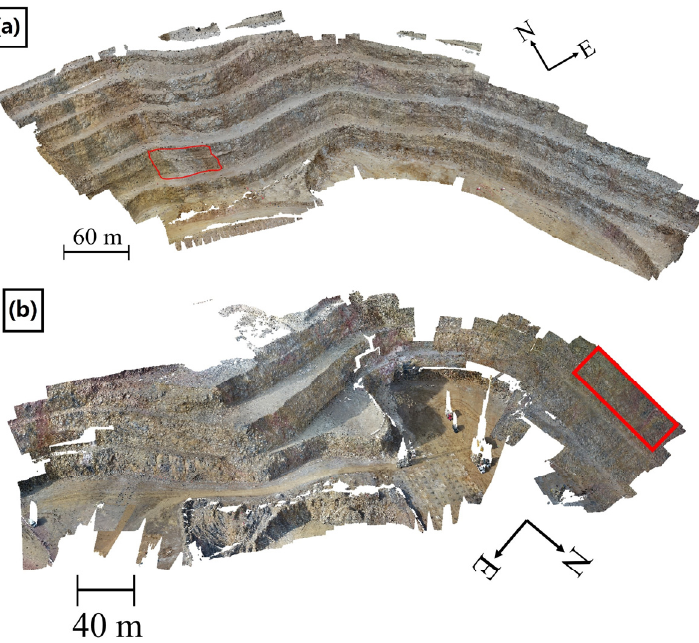
Figure 3. ( a ) Dense point clouds created from pit wall images of Top Pit. ( b ) Dense point clouds created from pit wall images of Pick Pit. Point cloud generation was done via Agisoft Metashape on high-quality, mild-filtering setting. The regions in the red boxes are the study areas for dataset creation and analysis.